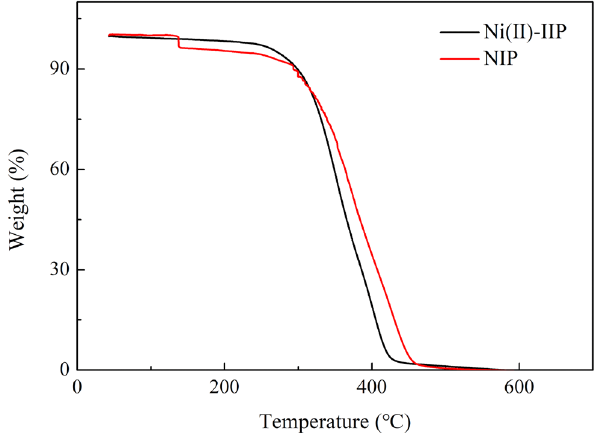
Figure 13: TGA curve of Ni ( II )- IIP 5 and NIP 5 .